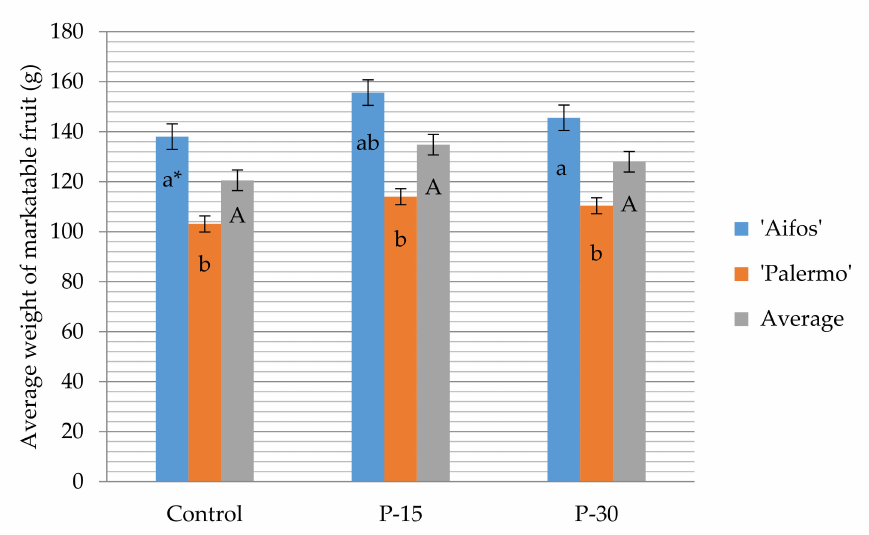
Figure 4. E ff ect of fertilizer with polyphosphates in hydroponic cultivation on the average weight of marketable fruit depending on the sweet pepper cultivar. * The bars marked with the same letters do not di ff er significantly according to the Tukey HSD test at α =